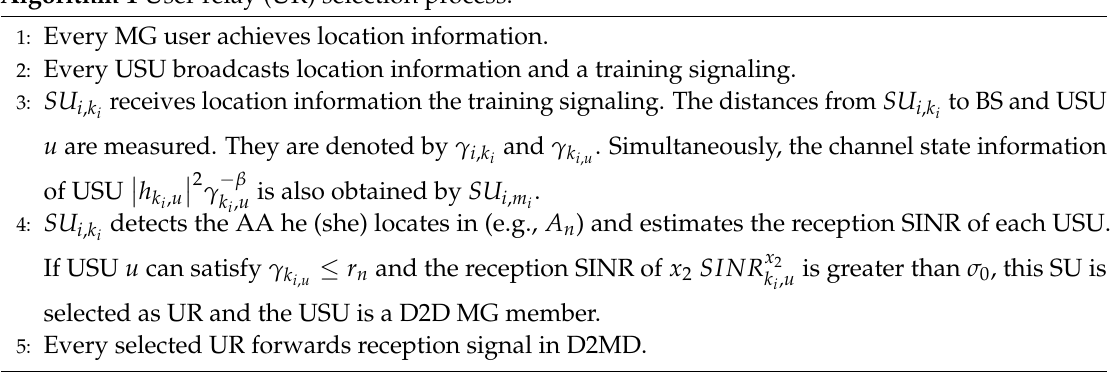
Algorithm 1 User relay (UR) selection